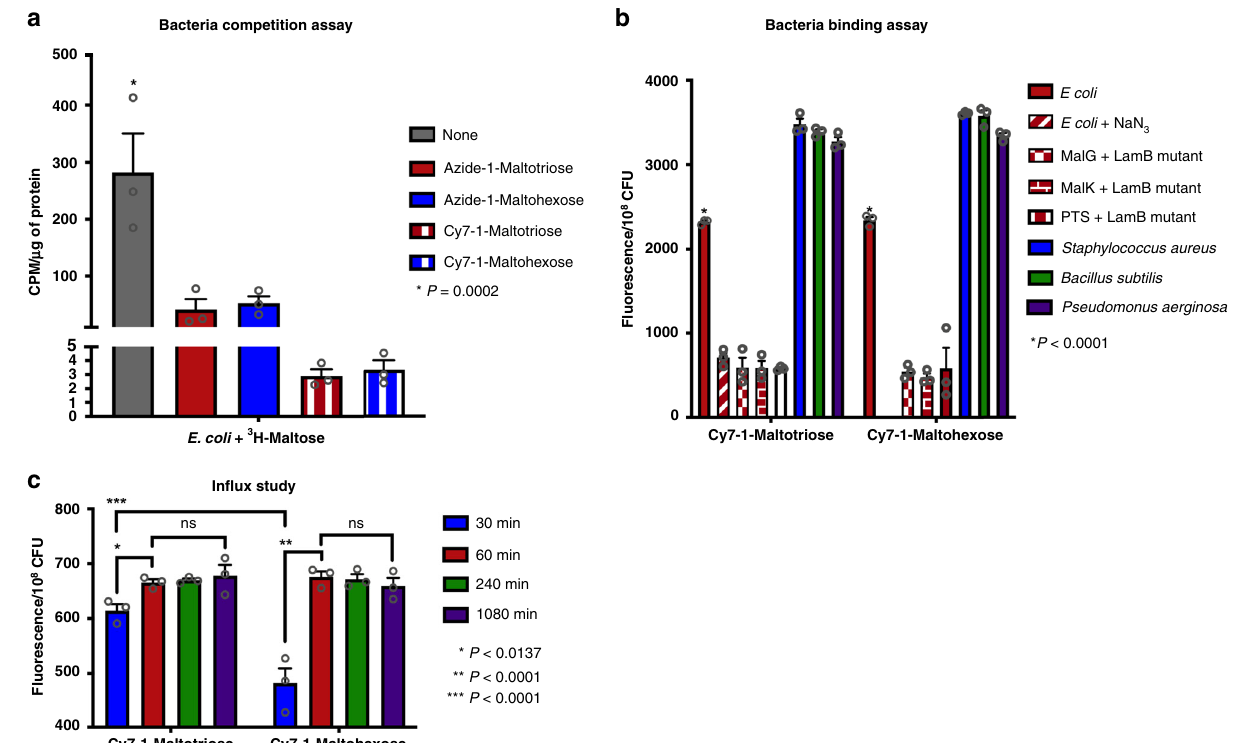
Fig. 2 In vitro evaluation of Cy7-1-maltotriose and Cy7-1-maltohexose. a Bar plot representation showing the effectiveness of 1-maltotriose and 1- maltohexose derivatives in competing with the uptake of 3 H-maltose in E. coli . Signi fi cant reduction in 3 H-maltose uptake in E. coli was observed with prior incubation with any of the 1-maltotriose or 1-maltohexose derivatives compared to E. coli incubated with only 3 H-maltose ( P = 0.0002, n = 3). Data are presented as counts per minute (CPM) in each sample normalized to protein content ( µ g of protein). b Bar plot representation showing quanti fi ed fl uorescence signal in E. coli , Staphylococcus aureus , Bacillus subtilis , and Pseudomonas aeruginosa after incubation with Cy7-1-maltotriose or Cy7-1- maltohexose. As a control, sodium azide-inactivated E. coli , and E. coli mutants lacking components of the maltodextrin transporter were tested. Signi fi cant reduction in Cy7-1-maltotriose uptake in inactivated E. coli and E. coli mutations was observed ( P < 0.0001, n = 3). Signi fi cant reduction in Cy7-1- maltohexose uptake in E. coli mutations was also observed ( P < 0.0001, n = 3). No signi fi cant difference in uptake between Cy7-1-maltotriose and Cy7-1- maltohexose in all bacteria strains was observed ( P > 0.05, n = 3). c Bar plot representation of in fl ux of Cy7-1-maltotriose and Cy7-1-maltohexose in E. coli overtime. Quanti fi ed fl uorescence signal from in fl ux study showcases signi fi cant increase in uptake of the probes when incubated for 60 min compared to 30 min incubation for both probes ( P < 0.0137 and P < 0.0001 for Cy7-1-maltotriose and Cy7-1-maltohexose, respectively, n = 3). In addition, signi fi cantly higher fl uorescence uptake of Cy7-1-maltotriose was observed compared to Cy7-1-maltohexose when incubated for 30 min was observed ( P < 0.0001, n = 3). Bar graphs show mean and S.E.M. Statistical analysis was performed using one- and two-way ANOVA. The source data underlying Fig. 2a – c are provided in a Source Data fi